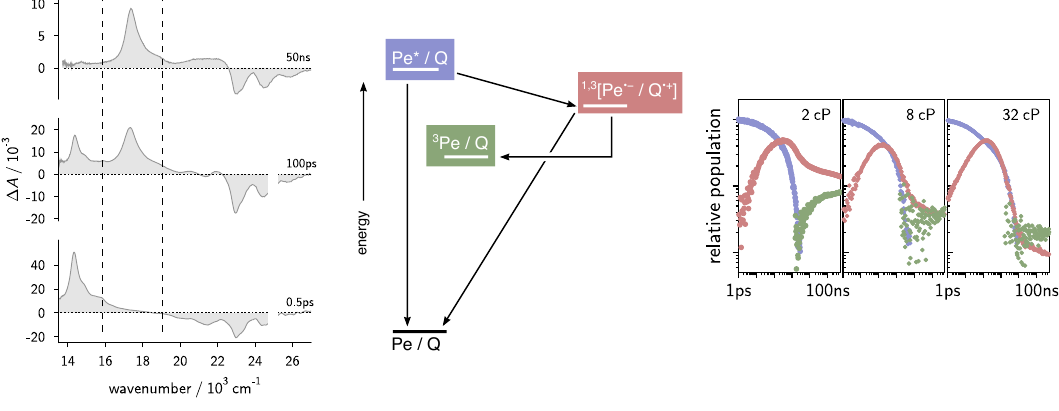
Figure 1: Selected transient spectra of photoinduced electron transfer between photoexcited perylene (Pe) and N,N-dimethylaniline (left panel), reaction scheme (middle panel, Q=DMA) and extracted concentration kinetics (right panel), blue 1 Pe ∗ , red Pe − and green 3 Pe